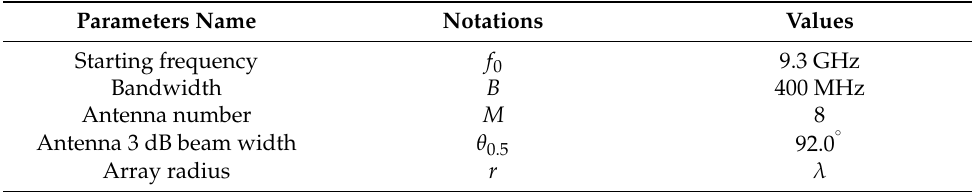
Table 7. Actual UCA radar parameters in the anechoic chamber experiments.